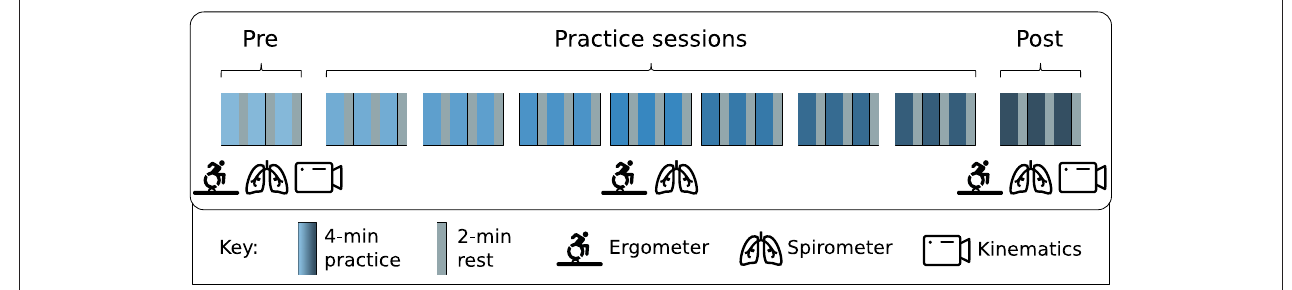
FIGURE 1 | Overview of the protocol: participants were tested on 9 occasions spread over three weeks with three blocks of practice each. Data were captured during all sessions, but kinematics were only recorded during the first- and last (pre and post)